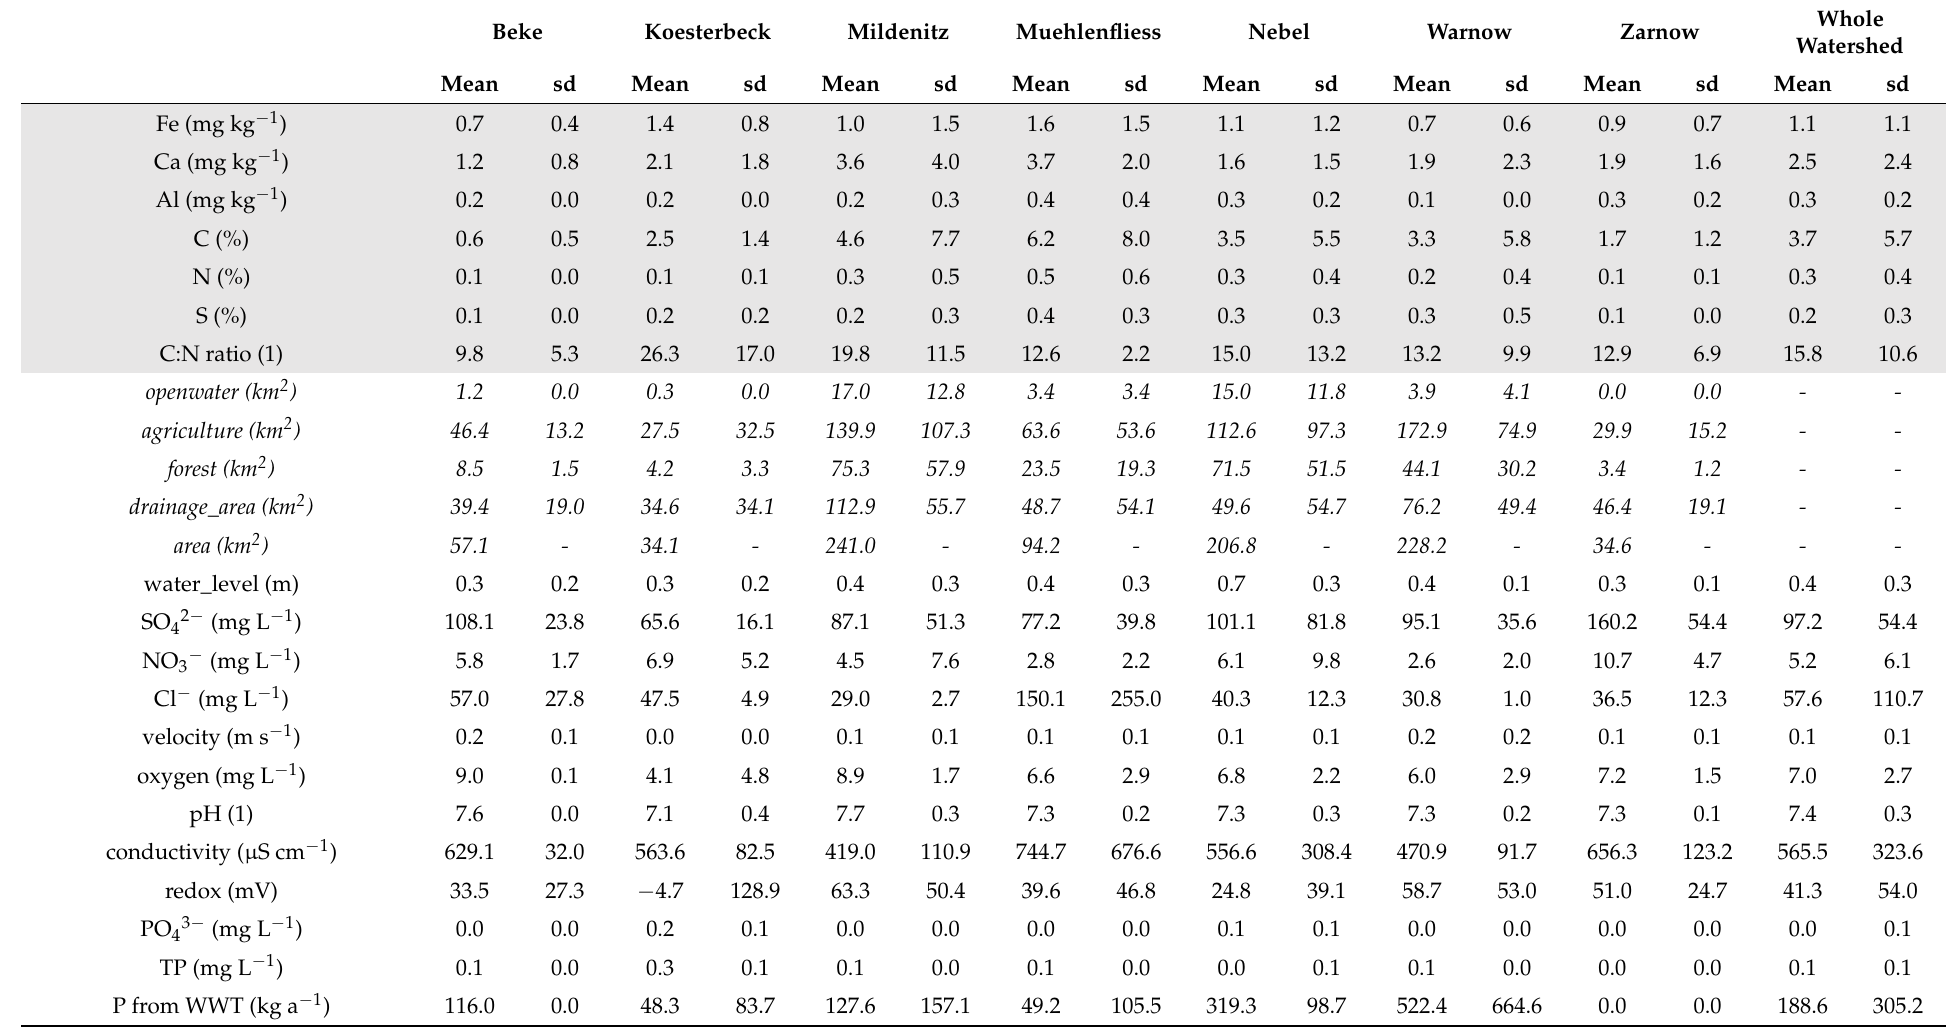
Table 3. Environmental parameters of all investigated sub-basins of Warnow River Watershed. Grey background: variables measured in sediment samples (all data given for 0–10 cm depth), italic: land use and area of the subbasins, all other variables are measured from water samples at the sampling spots. Beke Koesterbeck Mildenitz Muehlenfliess Nebel Warnow Zarnow